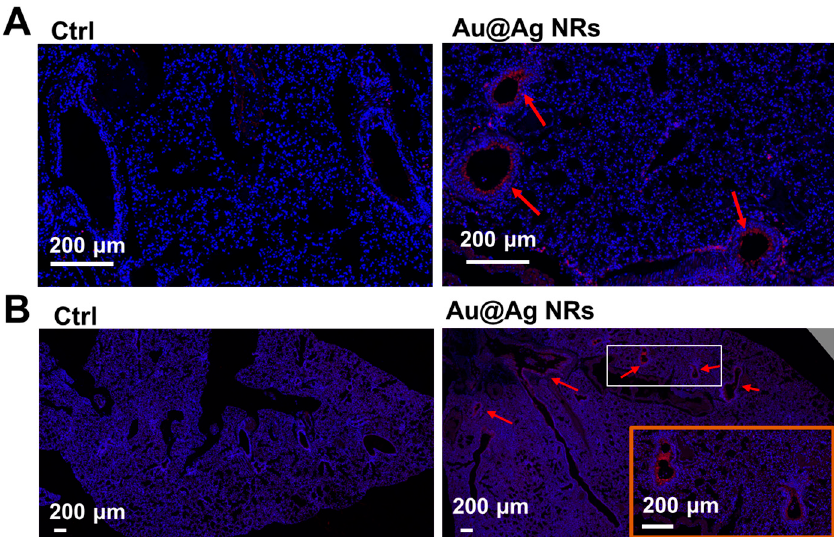
Figure 6. Influence of Au@Ag NRs on lung tissue. ( A ) IL-1 β level in the lungs from mice received multiple administration of Au@Ag NRs. IL-1 β was stained with red and indicated by red arrows, and the nucleus was stained with blue; ( B ) the level of tyrosine hydroxylase (TH) expression in the lungs visualized by immunofluorescence histochemistry. TH was stained with red and indicated by red arrows, and the nucleus was stained with blue. The inset in orange box is a magnification of the white box.